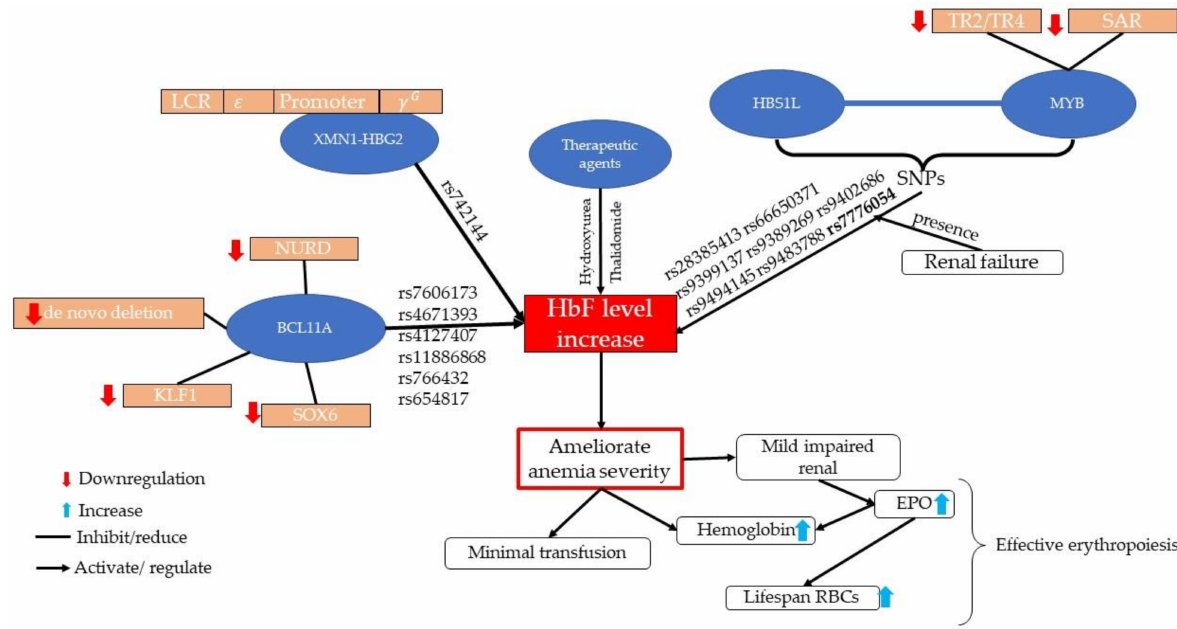
Figure 2. Pathway for regulation of γ -globin, possibly an increasing HbF level, and amelioration of anemia in XMN1-HBG2 , BCL11A , and HBS1L-MYB by the presence of SNPs, transcription factor, and a therapeutic agent. Table 1. SNPs found in XMN1-HBG2 , BCL11A , and HBS1L-MYB genes. Effects of